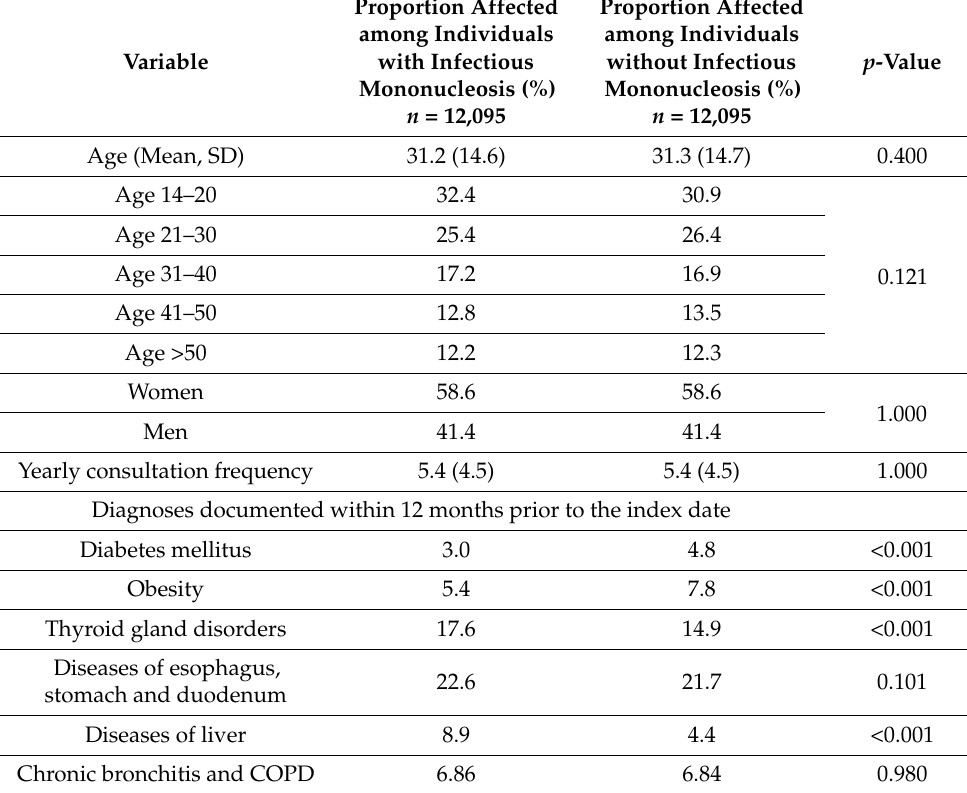
Table 2. Basic characteristics of the study sample (after 1:1 matching by propensity scores based on sex, age, index year, and yearly consultation